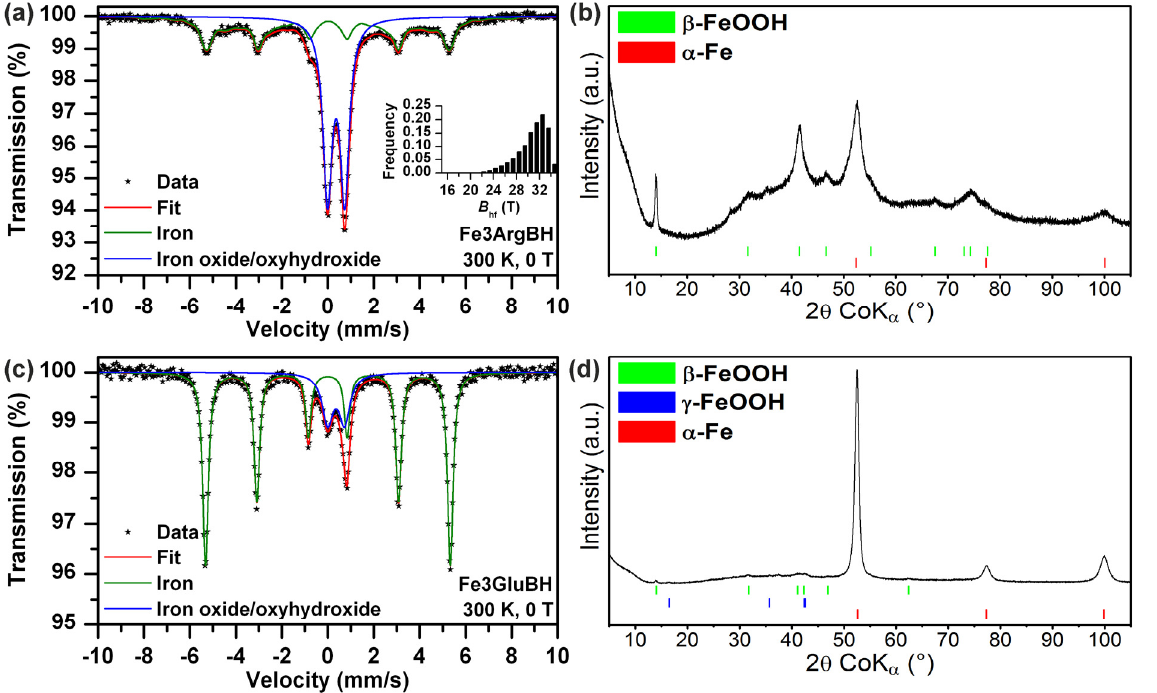
Figure 3. ( a ) Mössbauer spectrum of Fe3ArgBH recorded at room temperature; ( b ) X-ray powder diffraction (XRD) patterns of Fe3ArgBH; ( c ) Mössbauer spectrum of Fe3GluBH recorded at room temperature; ( d ) XRD patterns of